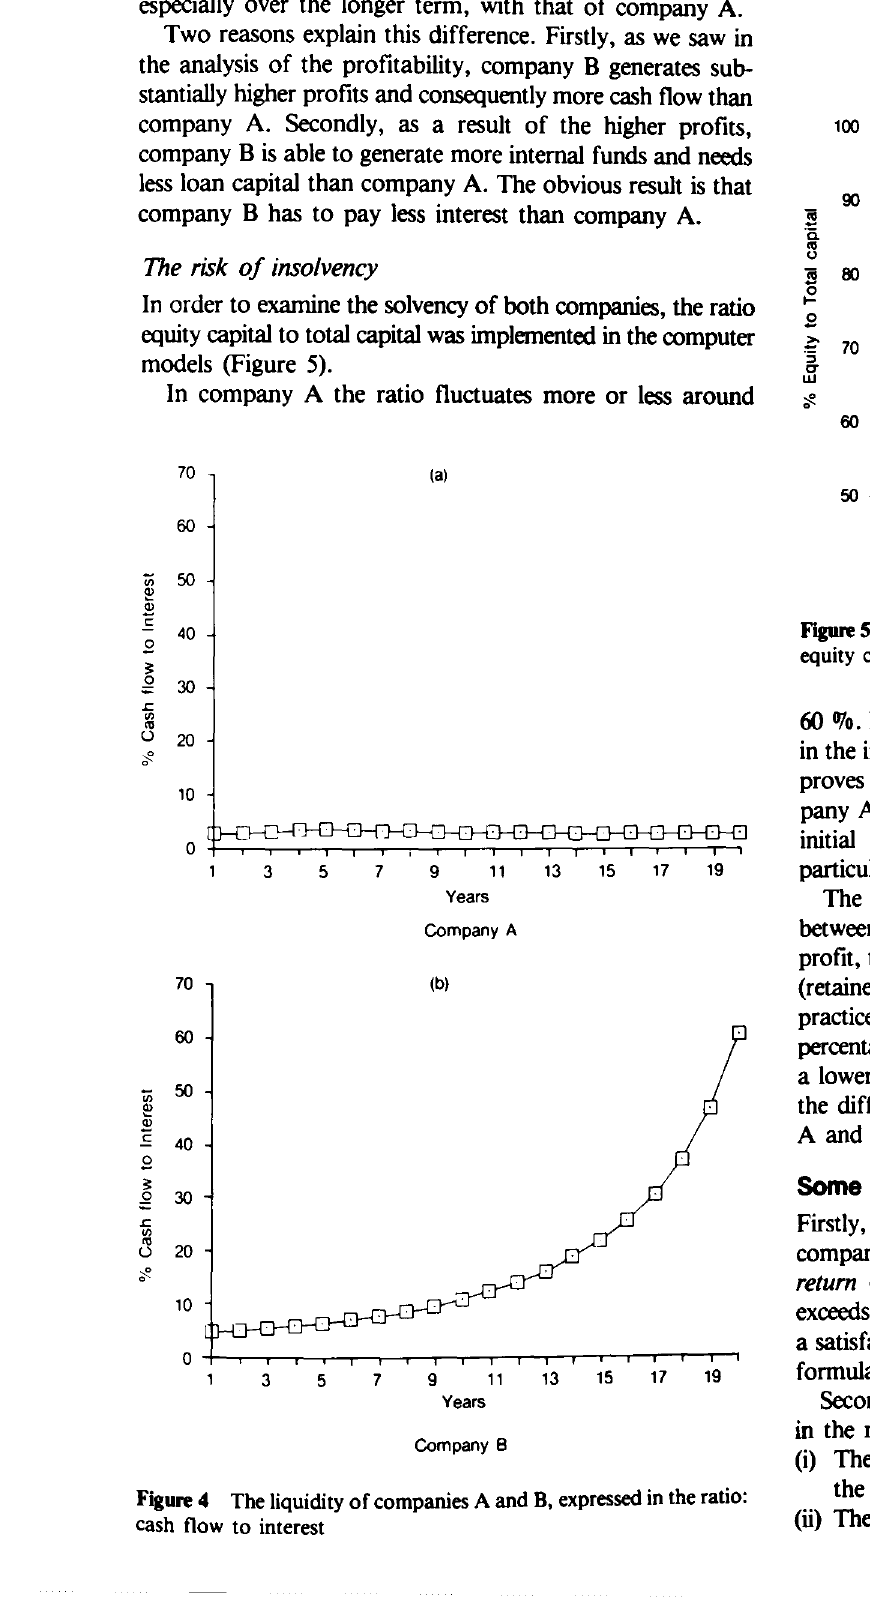
Figure 4 The liquidity of companies A and B, expressed in the ratio: cash flow to interest